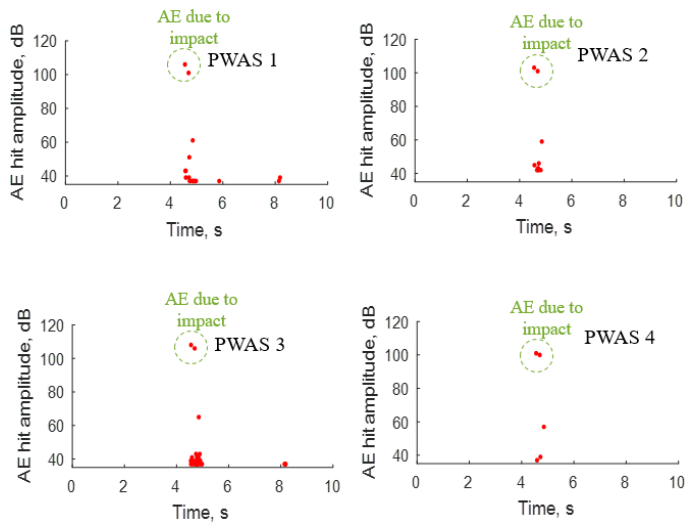
Figure 7. AE hits observed at the four PWAS due to 1 J impact event.